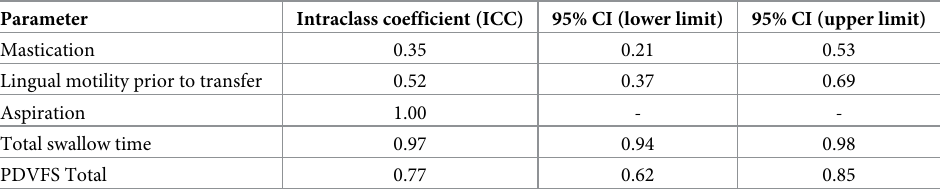
Table 5. Inter-rater reliability of PDVFS and composite